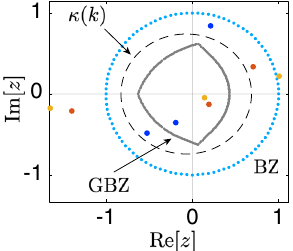
i [colored dots in Fig. 4] for a total of ν ( E r )